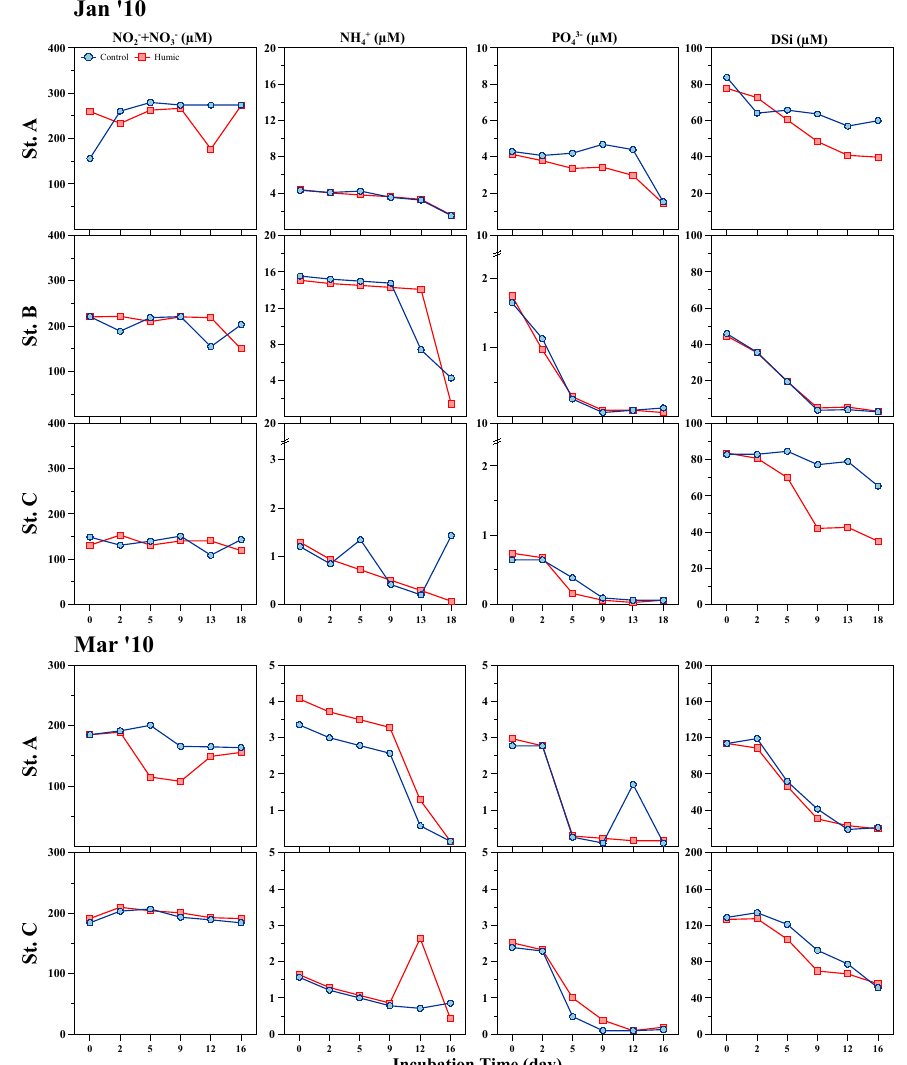
Figure 6. Nutrient concentrations, including nitrite + nitrate (NO 2 − + NO 3 − ), ammonium (NH 4+ ), orthophosphate (PO 43 − ; DIP), and dissolved silica (DSi), over the incubation periods of experiments conducted in January and March 2010.